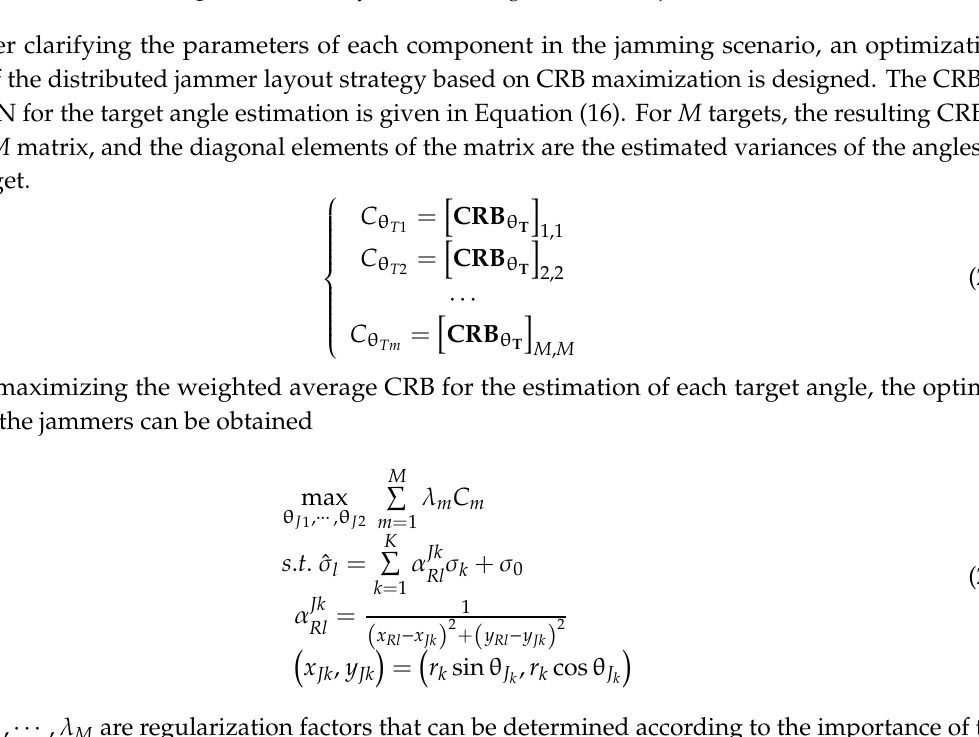
Figure 3. Geometry of the m th target and the k th